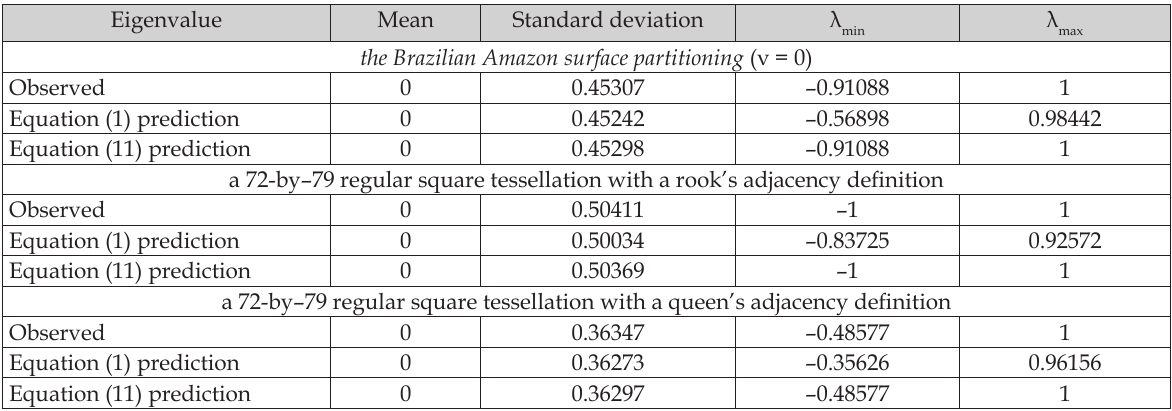
Table 2. Summary statistics for selected illustrative eigenvalue examples for matrix